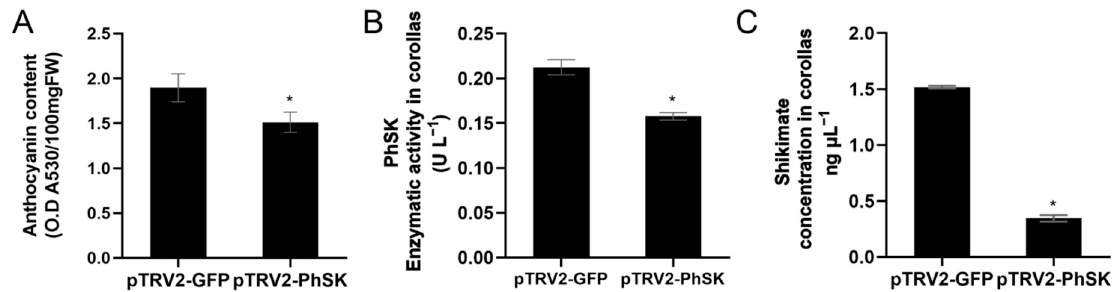
Figure 5. Effects of pTRV2-PhSK treatment on the anthocyanin content ( A ), enzymatic activity of SK ( B ), and shikimate content ( C ). The data are presented as the means ± SDs ( n = 3). The statistical analysis was performed using the one-way analysis of variance (ANOVA) followed by Duncan’s multiple range test (DMRT) with three biological replicates. * indicates significant differences at the p ≤ 0.05 level.